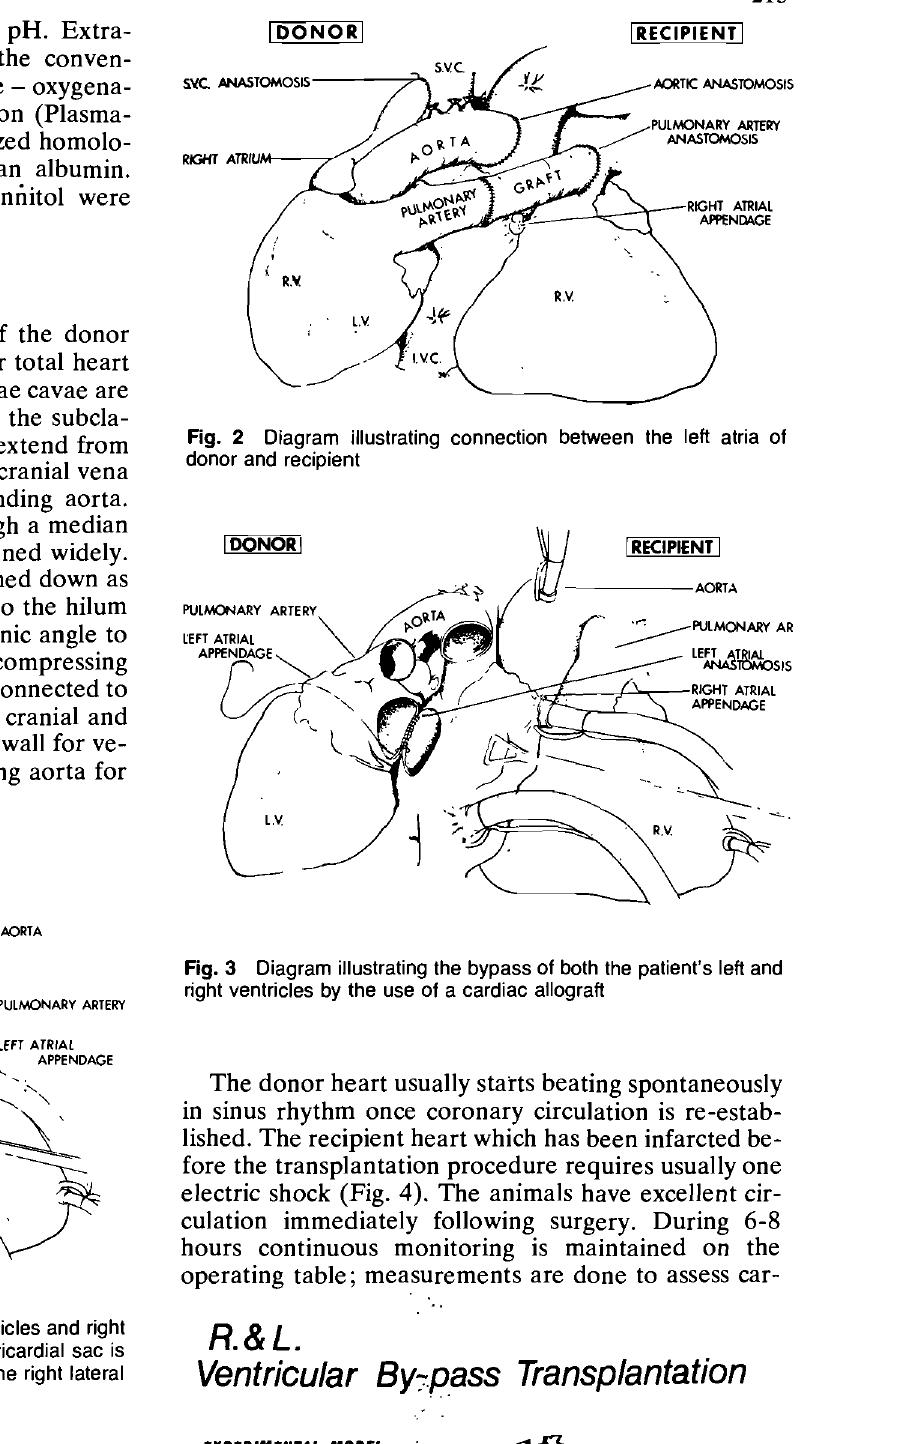
Fig. 1 Diagram of recipient's heart in situ, with ventricles and right atrium lifted towards the left. The right half of the pericardial sac is